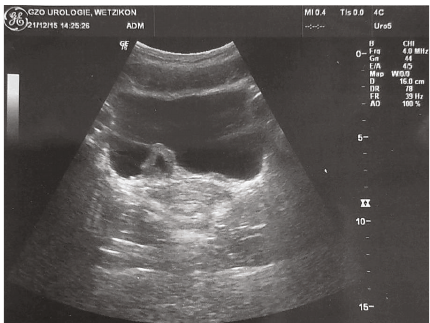
Figure 4: Transversal section of the sonographic control at the 12-month follow-up. The left-sided ureterocele can be seen side- inverted on the picture’s right side. Compared to the initial CT scan (Figure 3), there is a significant regression of the ureterocele in size.